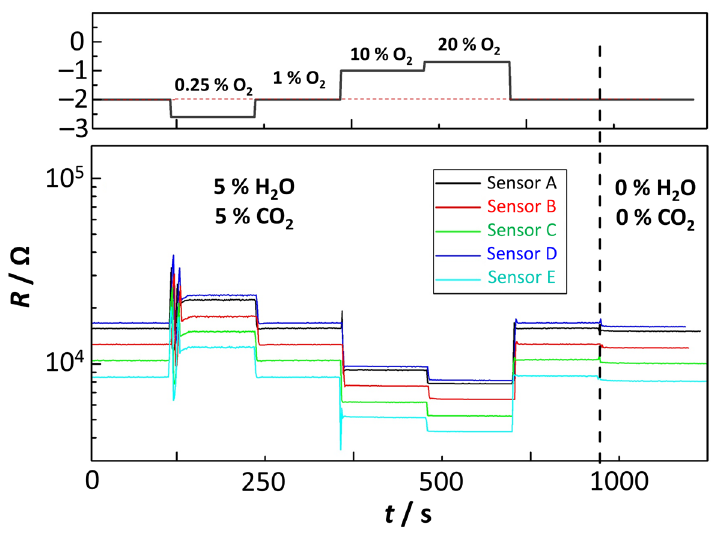
Figure 7. Sensor resistance R of several sensors at T Sensor = 750 °C and di ff erent p O2 .